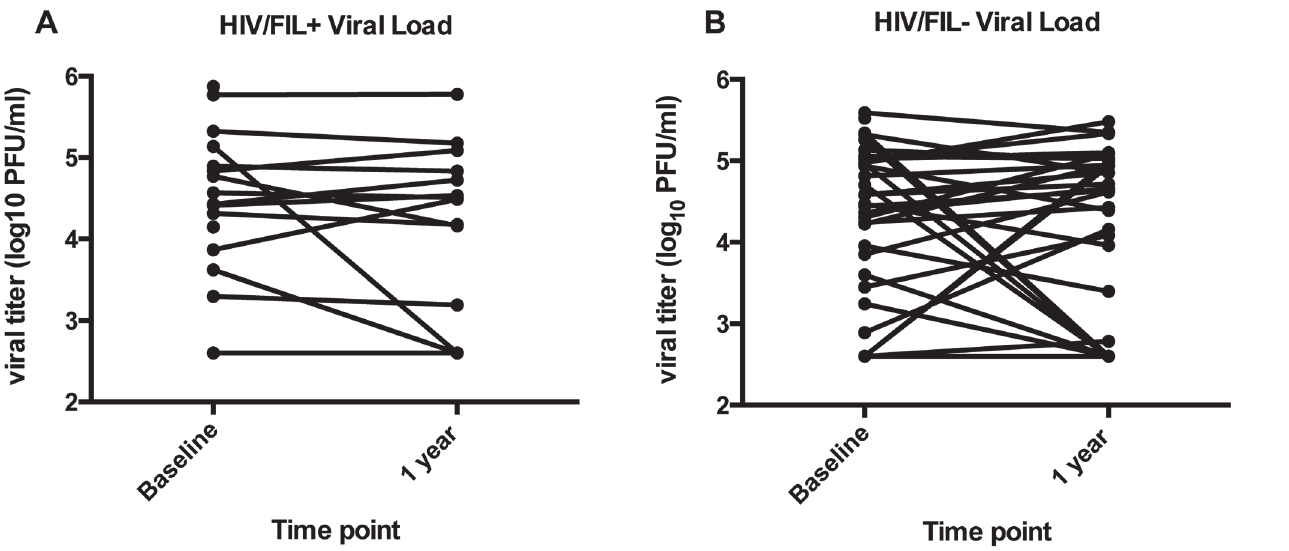
Fig 3. HIV viral load by over time by individual. HIV VL at baseline and 1 year in HIV+ /FIL+ individuals ( A ) and HIV+/FIL- individuals ( B ).